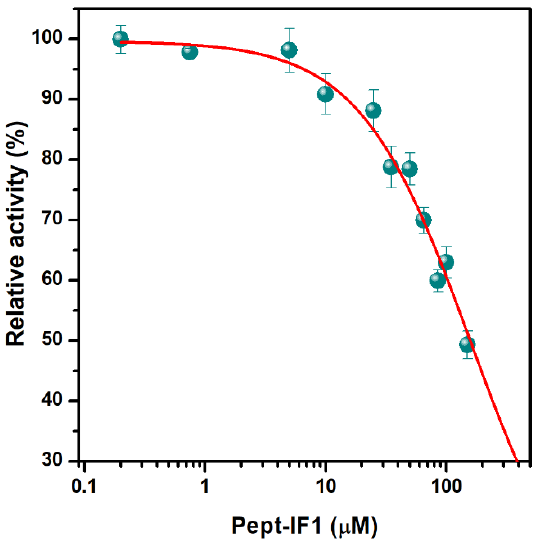
Figure 5. Dose-response plot of the inhibitory effect of Pept-IF1 on EcF 1 . Residual ATPase activity was measured using peptide concentration in the 1.25 – 150  M range, in a 100 mM Tris-SO 4 buffer solution with 1% DMSO (pH 8.0), 25 °C. The Hill equation was fitted to the experimental data, ob- taining IC 50 = 155 ± 14  M, h = 1.1 ± 0.1, v r = − 1 ± 3%. Data represent the average ± standard deviation of 3 independent